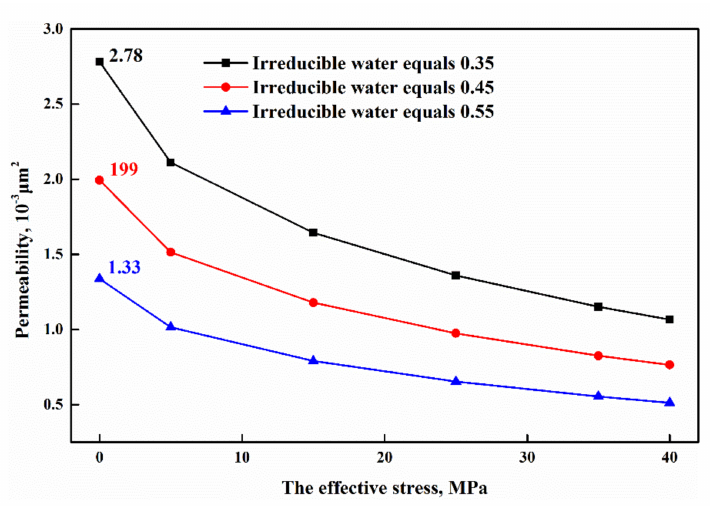
Figure 6. The effect of irreducible water on permeability under various effective